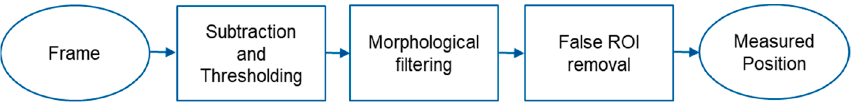
Figure 2. Block diagram of moving object